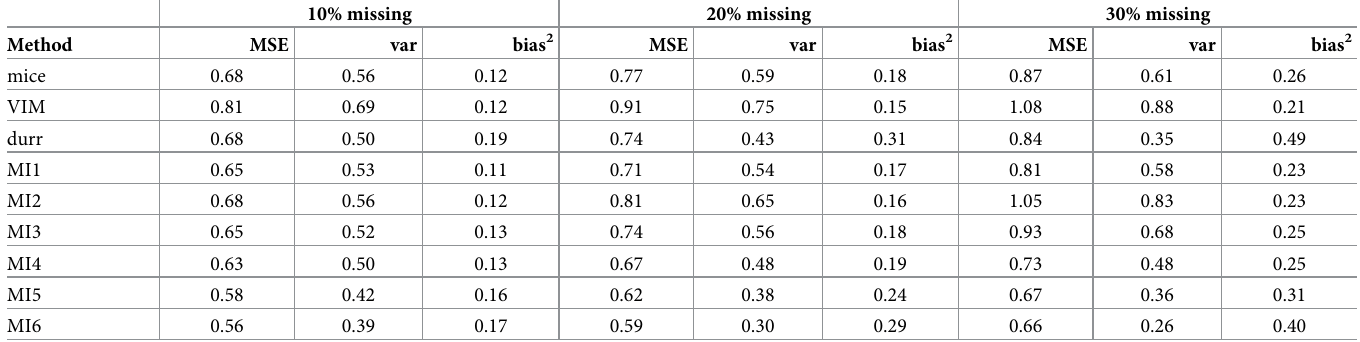
Table 4. Heart data results of MSE with its split into variance and bias components. The results are obtained when a ridge regression was fitted to the data imputed with all proposed and existing imputation